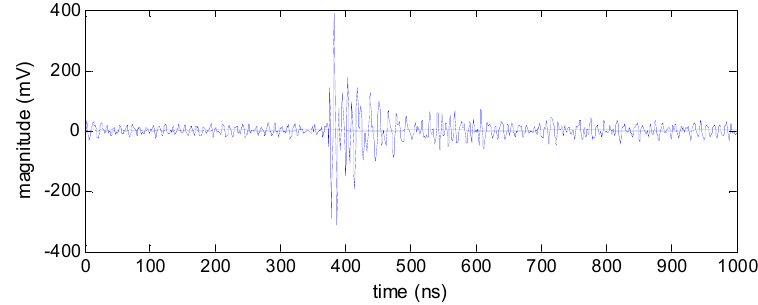
Figure 10. A typical ultra ‐ high ‐ frequency (UHF) PD signal measured by an